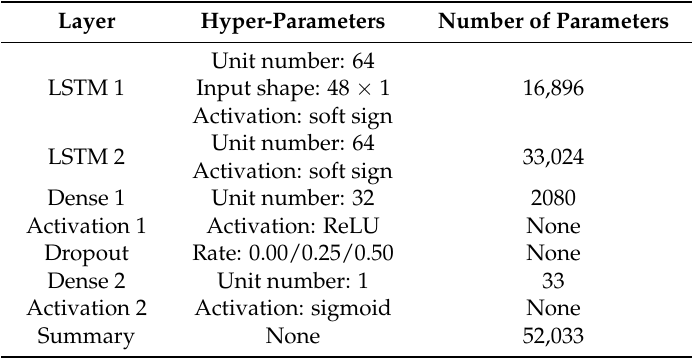
Table 1. The structure of the proposed LSTM network.